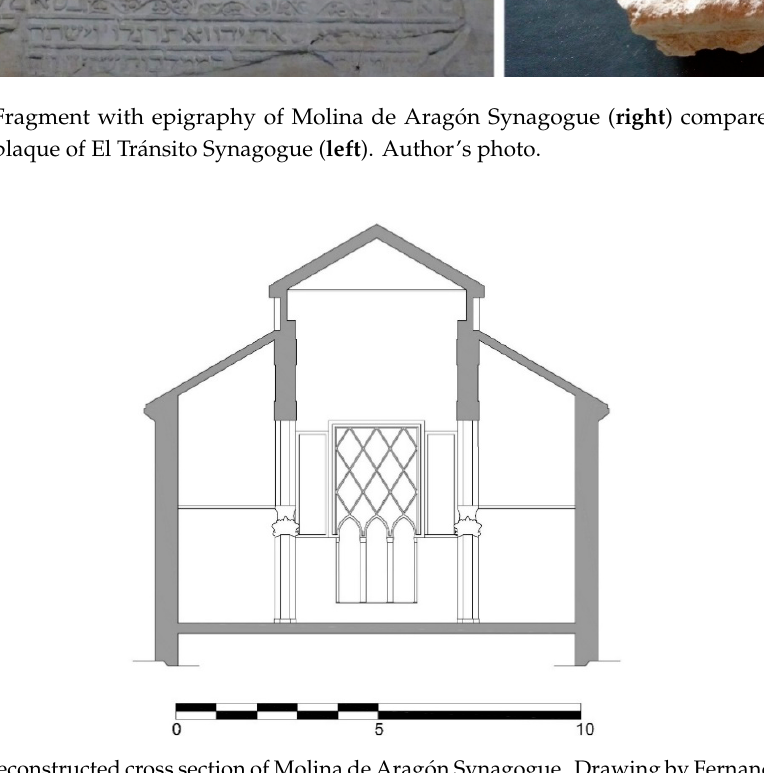
Figure 22. Reconstructed cross section of Molina de Aragón Synagogue. Drawing by Fernando Lechuga. Used by permission.